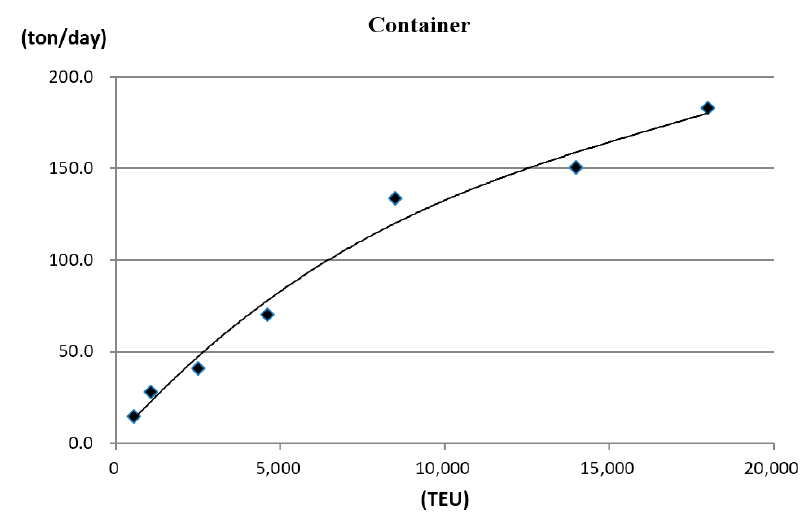
Figure 2. Daily LNG Fuel Consumption of Container.